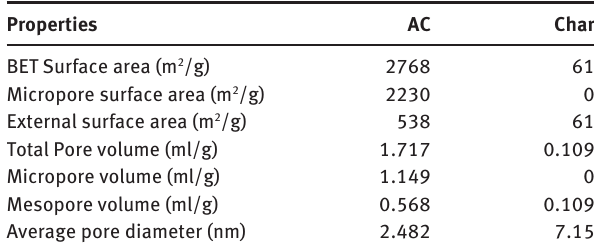
Table 2: Pore structural parameter of high surface area activated carbon (HSAAC) versus char.